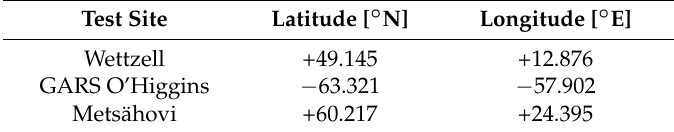
Table 2. Image center coordinates of the datatakes underlying our